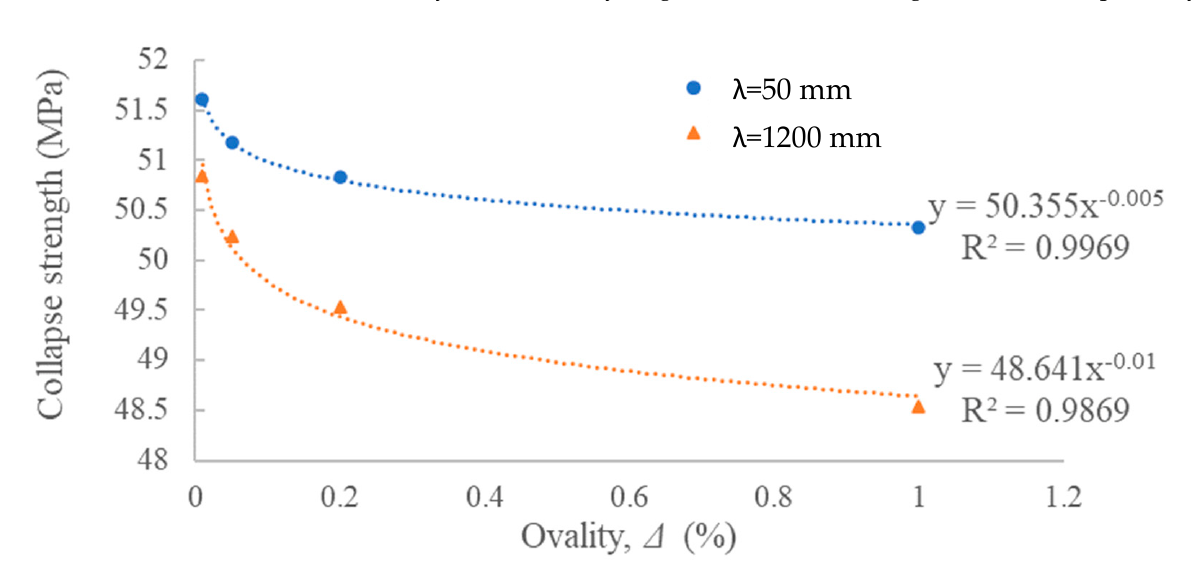
Figure 6. Relationship between collapse strength and ovality length of case series of ‘313 de ’. After summarizing all 1200 calculation cases, a fitted equation is derived, 𝑃 (cid:2916)(cid:2919)(cid:2930) (cid:3404) 𝐶 𝑒 (cid:3040)(cid:3031) (cid:3057)(cid:2878)(cid:3041)(cid:3039) (cid:3090) / (cid:3019) (cid:3173) (3) where 𝑚𝑑 (cid:3404) (cid:3398) 0.2816 (cid:4672) (cid:3019) (cid:3173) (cid:3019) (cid:3167) (cid:4673) (cid:2870) (cid:3397) 0.9743 (cid:4672) (cid:3019) (cid:3173) (cid:3019) (cid:3167) (cid:4673) (cid:3398) 0.8525 𝑛𝑙 (cid:3404) (cid:3398) 0.1516 (cid:4672) (cid:3019) (cid:3173) (cid:3019) (cid:3167) (cid:4673) (cid:2870) (cid:3397) 0.5229 (cid:4672) (cid:3019) (cid:3173) (cid:3019) (cid:3167) (cid:4673) (cid:3398) 0.4617 𝐶 (cid:3404) 𝑘 (cid:3030) (cid:4672) (cid:3019) (cid:3047) (cid:4673) (cid:3397) 𝑏 (cid:3030) , (cid:3019) (cid:3047) (cid:3404) (cid:4672) (cid:3019) (cid:3173) (cid:3047) (cid:3173) (cid:4673) (cid:2869) / (cid:2871) (cid:4672) (cid:3019) (cid:3167) (cid:3047) (cid:3167) (cid:4673) (cid:2870) / (cid:2871) 𝑘 (cid:3030) (cid:3404) (cid:3398) 0.5867 (cid:4672) (cid:3019) (cid:3173) (cid:3019) (cid:3167) (cid:4673) (cid:3398) 0.1918 , 𝑏 (cid:3030) (cid:3404) 65.94 (cid:4672) (cid:3019) (cid:3173) (cid:3019) (cid:3167) (cid:4673) (cid:3398) 11.62 In Equation (3), the expression of fitted collapse strength ( P fit ) contains several con ‐ stants. These constants are regarded as the effect of material properties of SPs. The accuracy of Equation (3) is checked. Some cases from Group 1 have large errors. In these cases, the value of λ / R o is too large, for example, when λ = 1200 mm, the value of λ / R o is 20. A large value of λ / R o means the ovality area occurred to a large part of SPs. The issue discussed in this research focuses on the local buckling so that the cases with λ / R o ratios large than 16 are removed. Therefore, 1136 cases are summarized. The comparison result of the other cases between fitted equation and calculation is shown in Figure 7, in which good agreement is achieved.